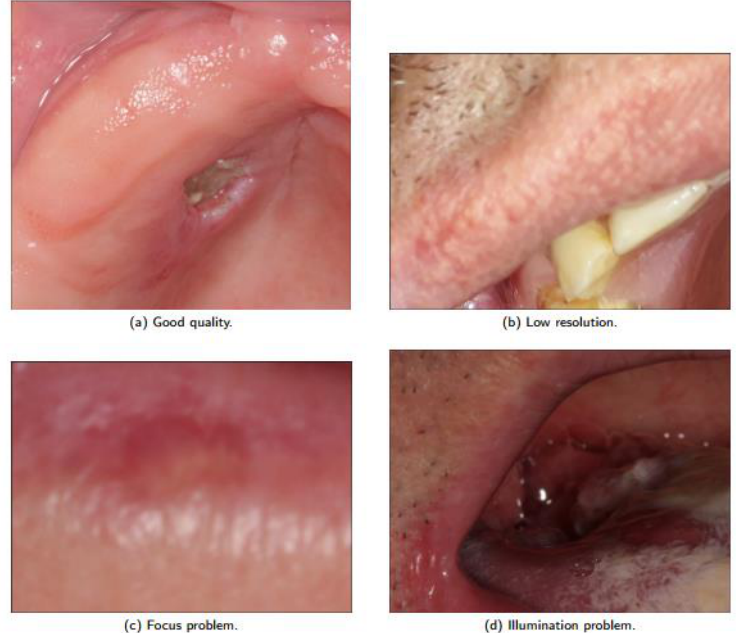
Figure 3. Dataset quality image variation.